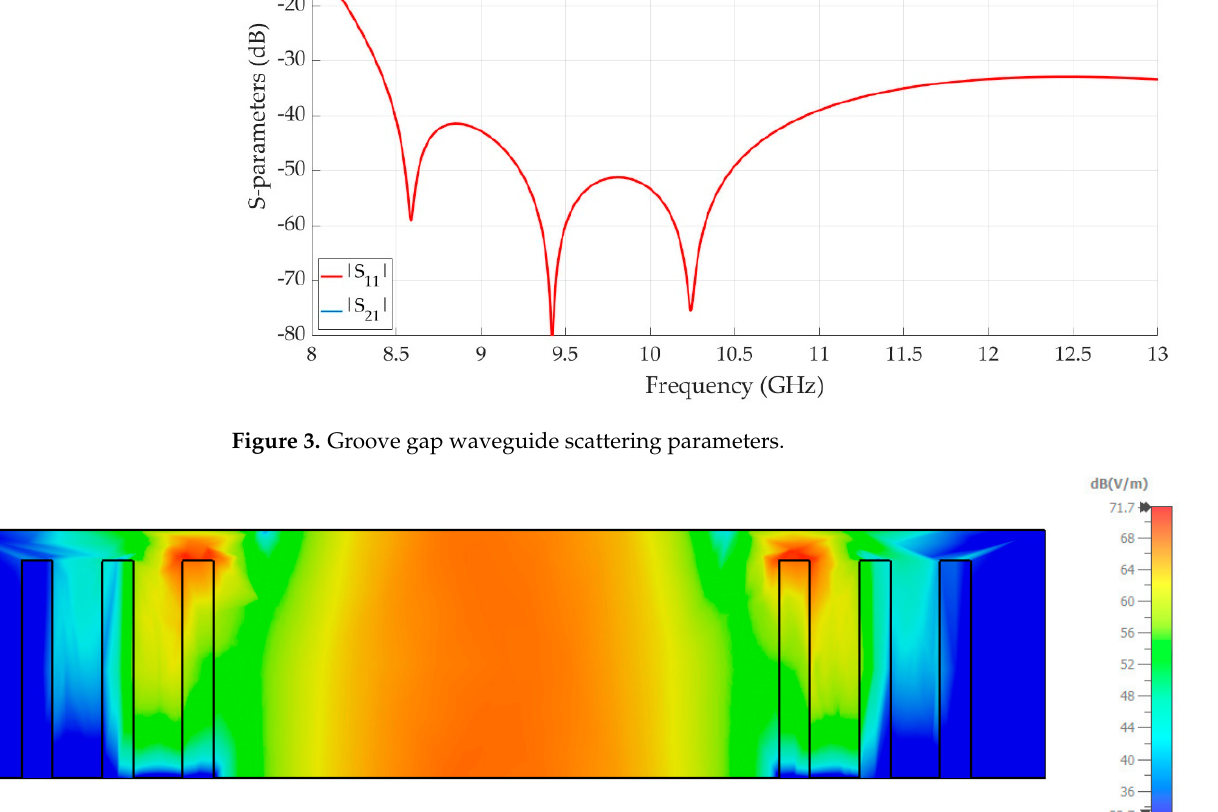
Figure 4. Groove gap waveguide cross-section electric field @ 9.5 GHz.